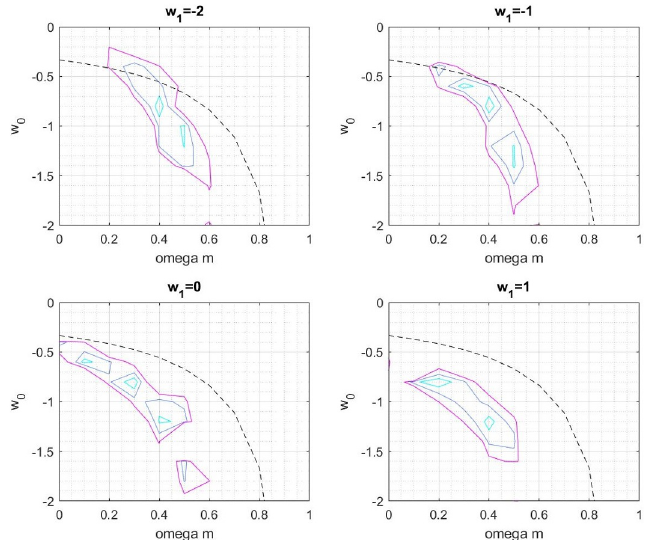
Figure 6: Plots of w 0 against Ω m for values of − 2 < w 1 < 1, with 1 σ , 2 σ and 3 σ contours. The best fit values are Ω m = 0 . 4, w 0 = − 0 . 8, w 1 = − 1, with a χ 2 value of − 227 .